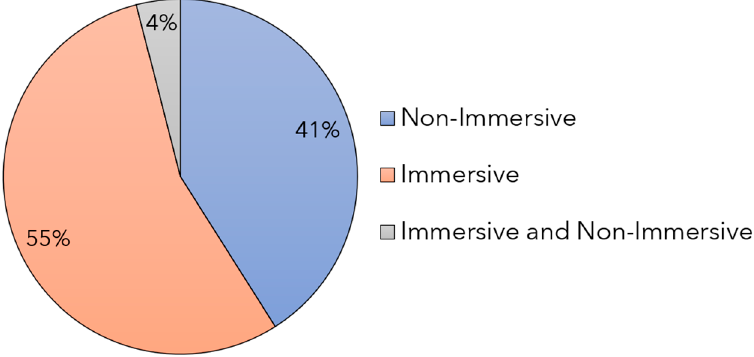
Figure 2. Status of Utilization of Immersive and Non-immersive simulators in MET.